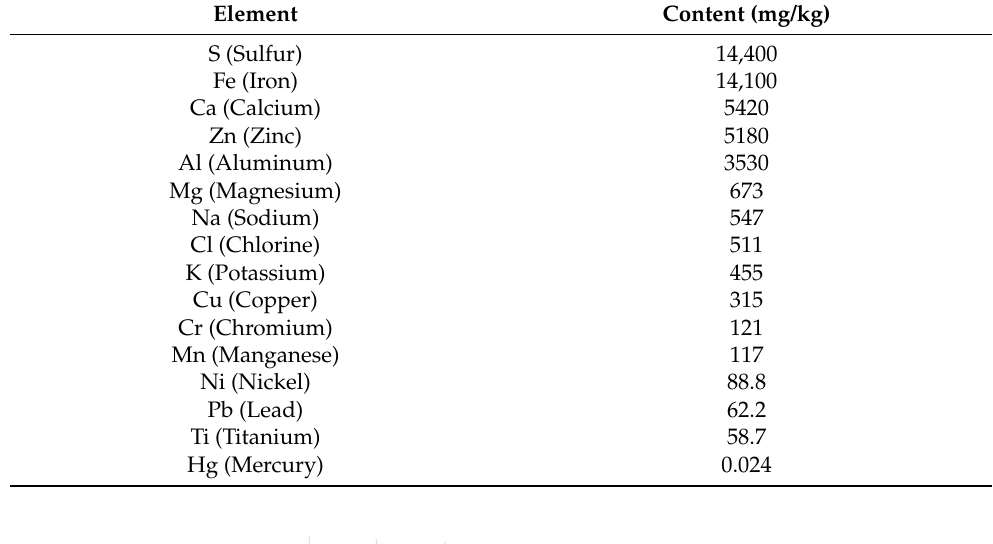
Table 2. Elemental contents of KDP20 by coupled plasma optical emission spectrometry (ICP-OES), cold vapor atomic absorption spectrometry (CV-AAS), and combustion ion chromatography (C-IC) analysis at a detection limit of 0.1 mg/kg.